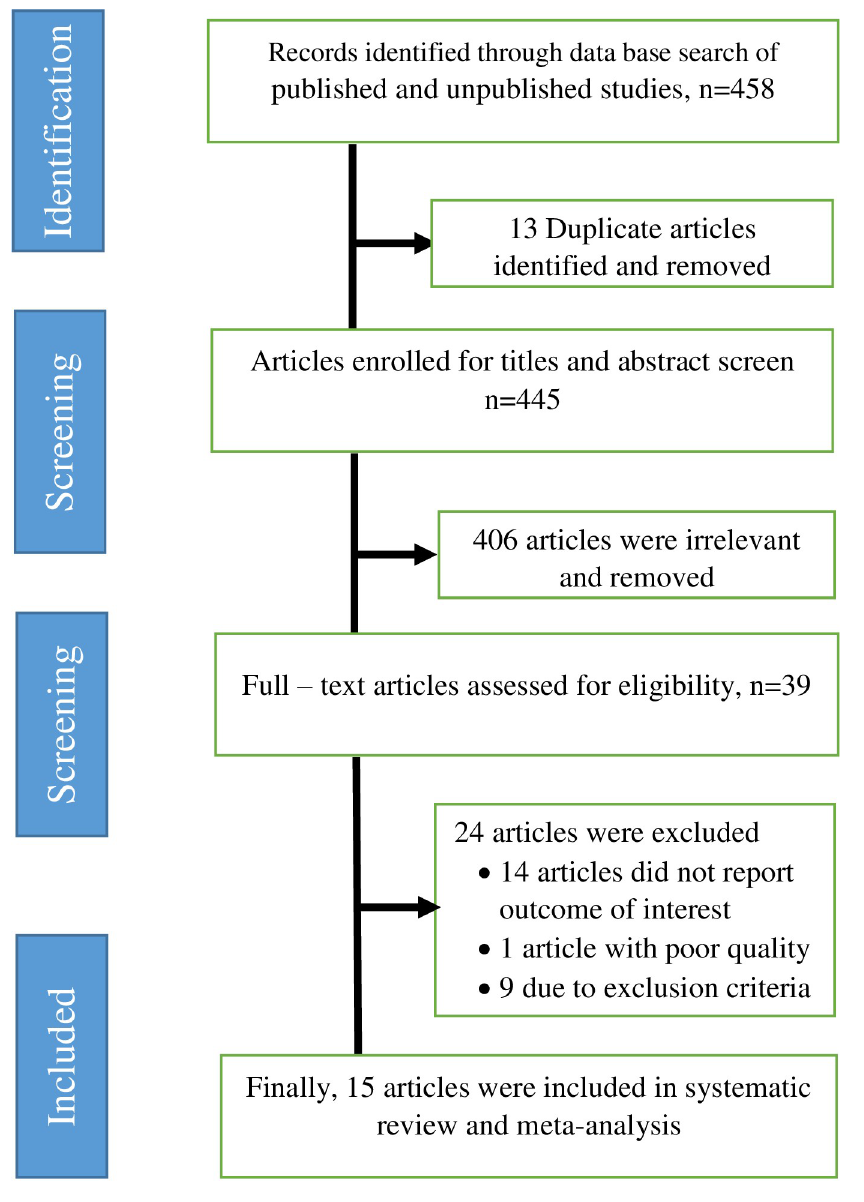
Fig 1. PRISMA flowchart diagram of the study